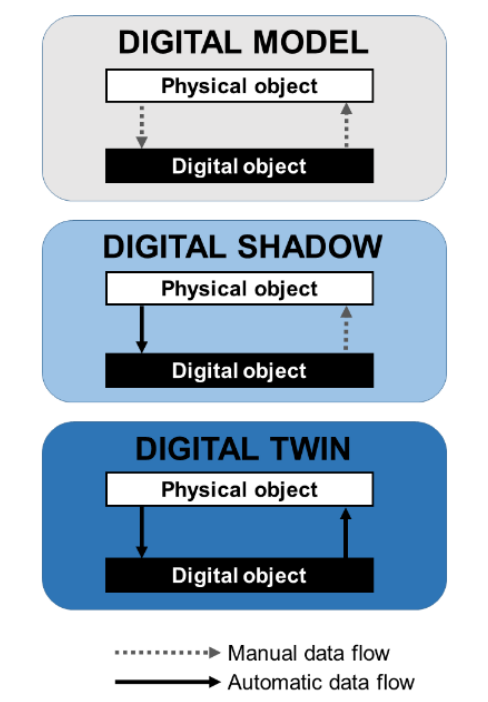
Figure 1: Data flow in digital model, digital shadow, and digital twin. (Modified from